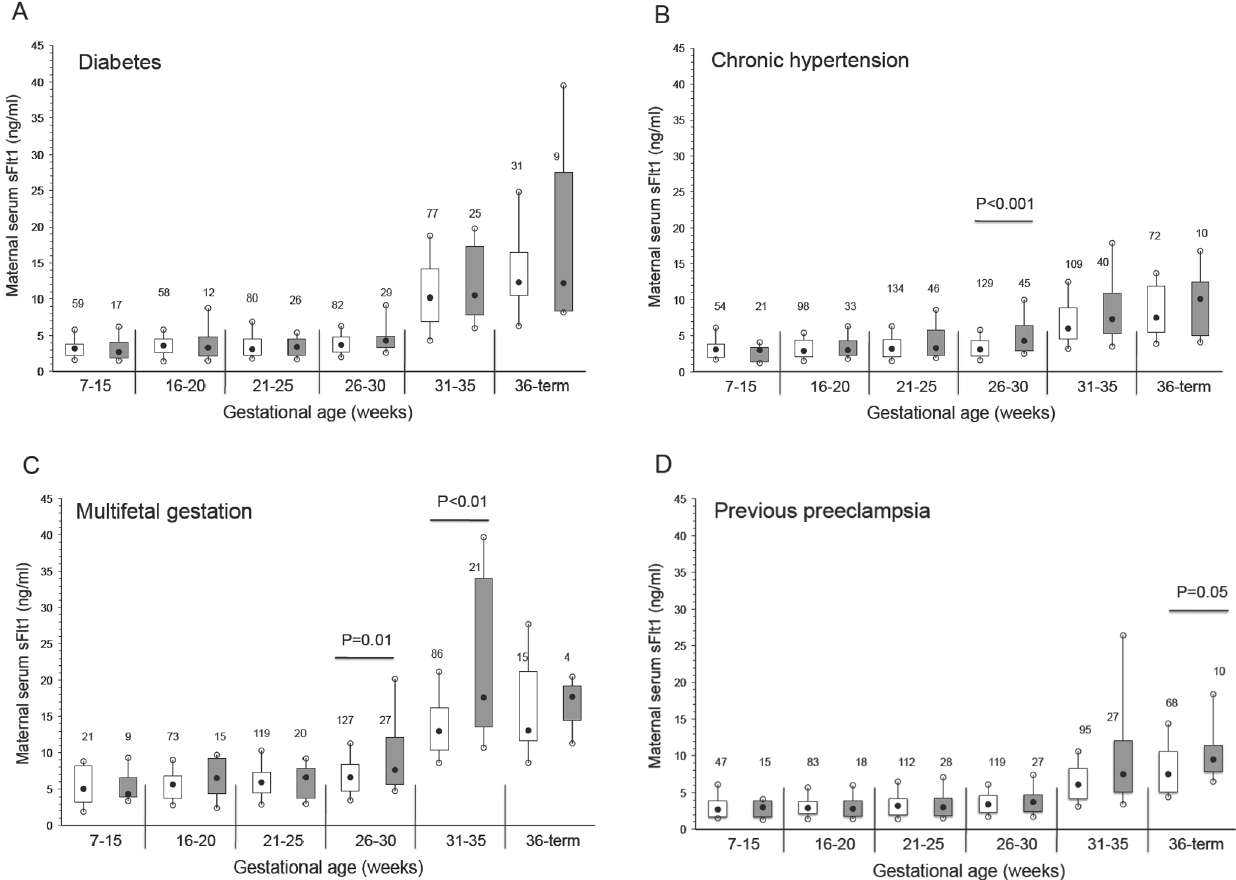
Figure 1. Maternal serum sFlt1 across gestation in women with pre-existing diabetes (A), chronic hypertension (B), multifetal gestation (C), and previous preeclampsia (D). Open boxes are controls and shaded boxes are subjects who developed preeclampsia. The number above each box indicates the number of samples. The filled black circles are the median, the open circles are the 90th and 10th percentiles, and the top and bottom lines of the box are the 75 th and 25 th percentiles of the data for each group. Statistical significance is indicated by p values.